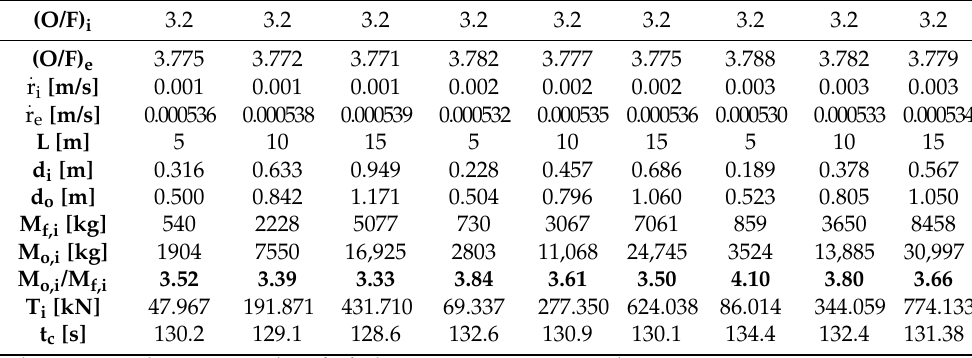
Table 5. Numerical results for R TM,i = 2 and imposed L,